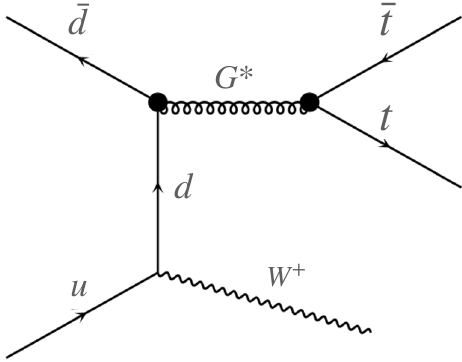
Figure 7 . A representative Feynman diagram of the process pp → t ¯ tW mediated by a KK gluon. This is only one of the 8 diagrams containing a KK gluon out of a total of 76 involved in the process.